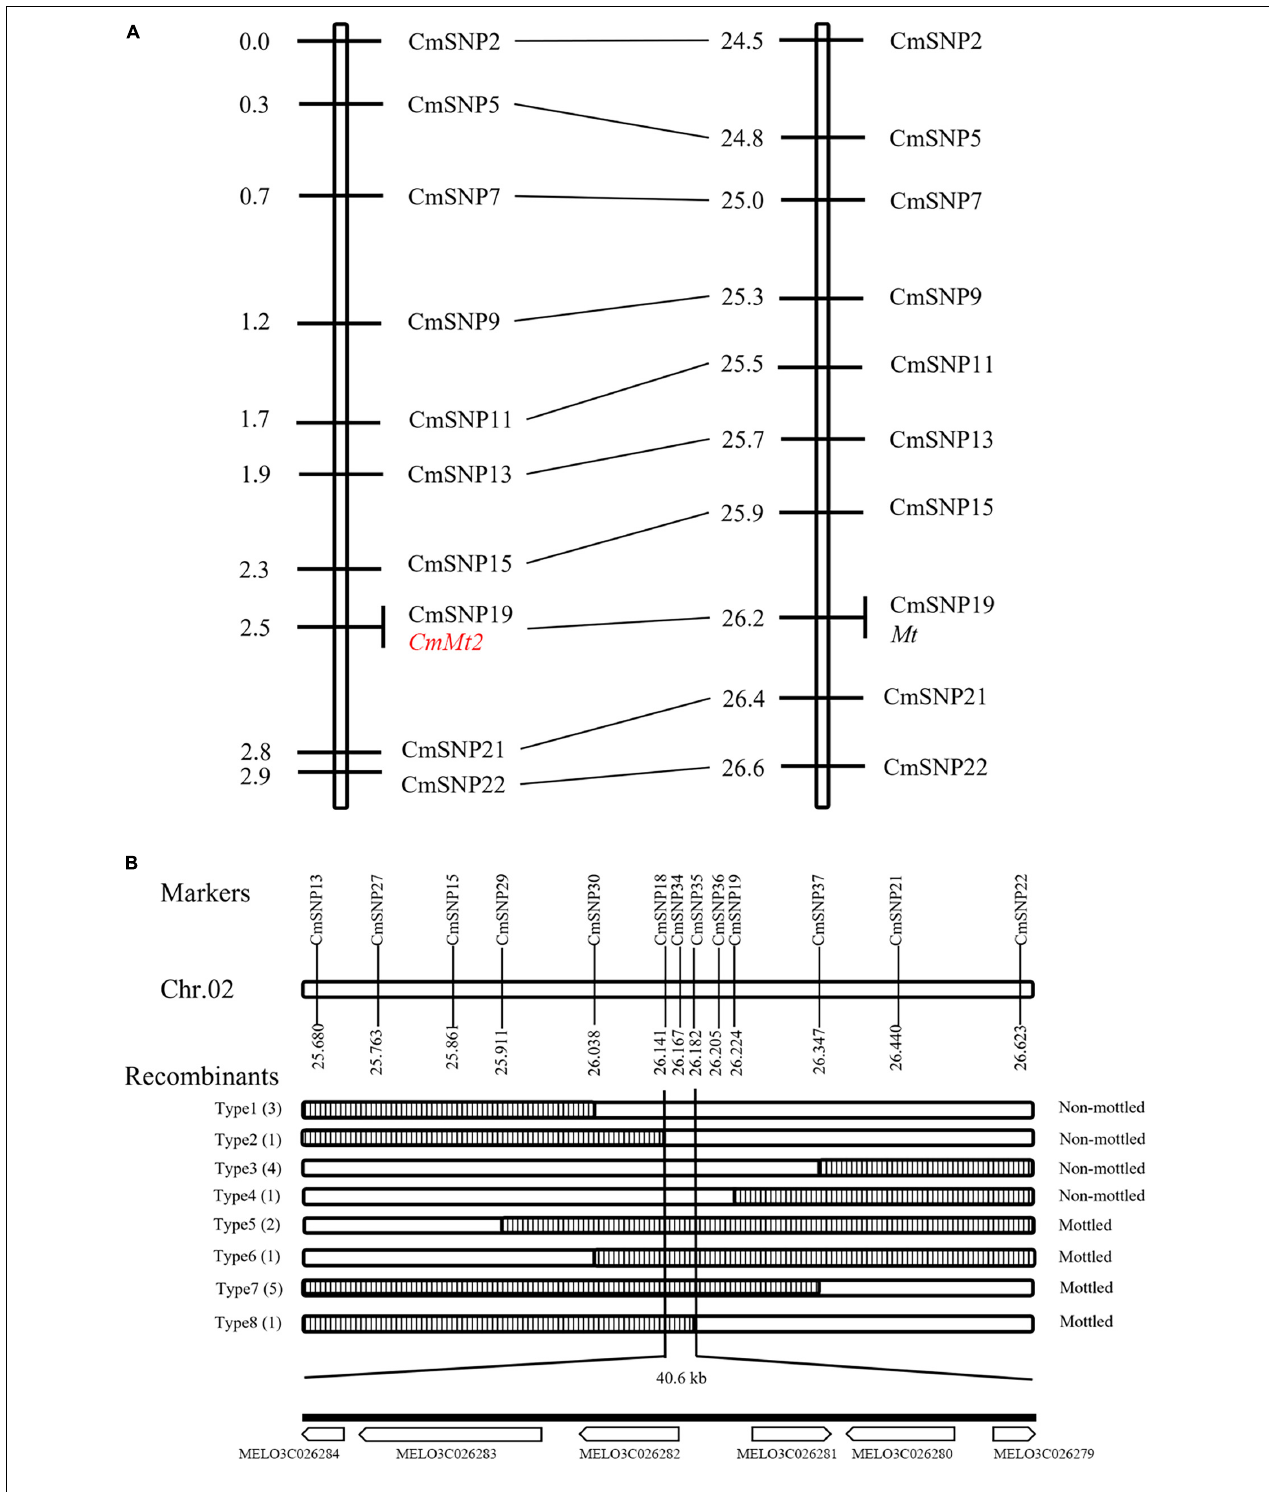
FIGURE 5 | Initial and fine mapping of the CmMt2 gene in melon. (A) Initial mapping of CmMt2 . Genetic map of CmMt2 is on the left, with cM as the unit. The corresponding physical map (right, unit: Mb) is also shown. (B) Fine mapping of CmMt2 . The CmMt2 gene was delimited to an interval between CmSNP18 and CmSNP35, with an estimated length of 40.6 kb, and six genes were annotated in this region based on the reference genome sequence. The genetic structure of each recombinant type is depicted as white for homozygous non-mottled rind and striped for heterozygous mottled alleles. The number of each recombinant type is indicated in